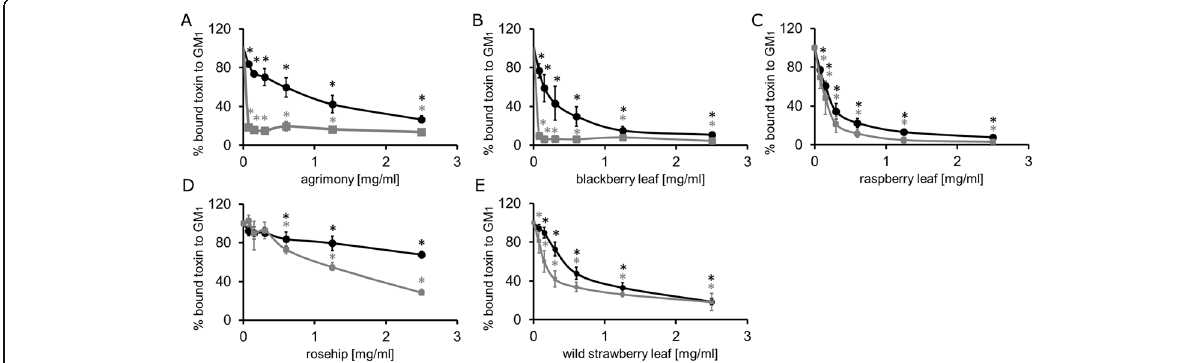
Fig. 4 Plant extract effects on the prevention of binding cholera toxin to immobilized GM 1 . Modified ELISA binding assay showing the amount of CTX (black) and CTB (grey) immobilized on GM 1 -coated microplates as a function of the 2.5 – 0 mg/mL aqueous plant extracts: a agrimony, b blackberry leaf, c raspberry leaf, d rosehip, e wild strawberry leaf. Values are mean ± standard error of six independent assays. * p < 0.01, compared with CTX or CTB